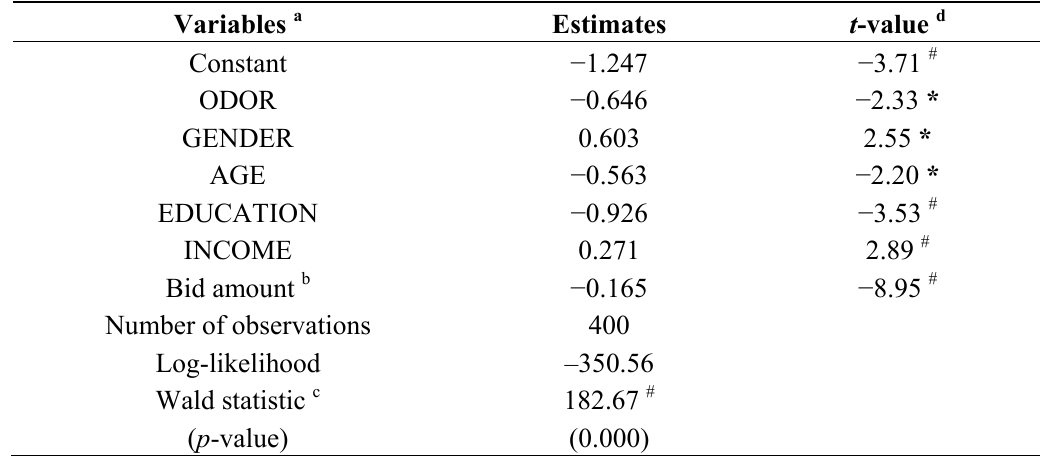
Table 4. Estimation results of the spike model with